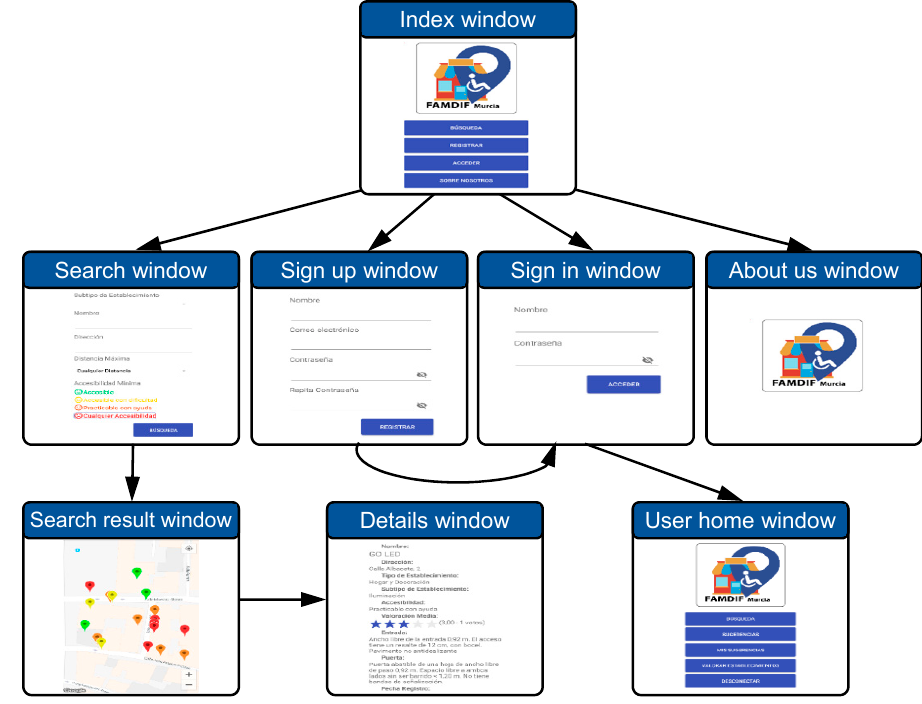
Figure 5. Navigation diagram of the app, corresponding to the role of unregistered user.